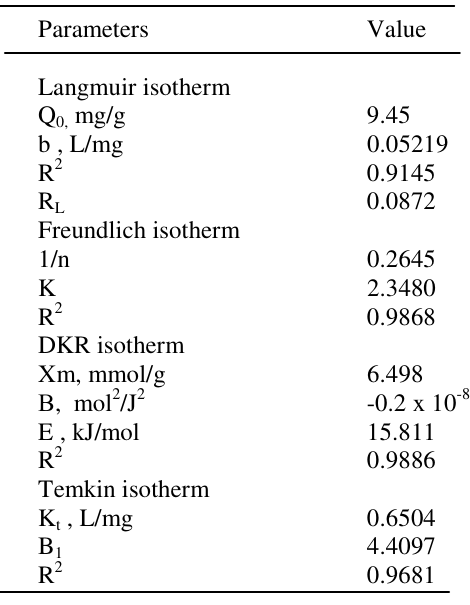
Table 5. Langmuir, Freundlich, DKR, and Temkin parameters of sorption isotherm for Cu (II) on